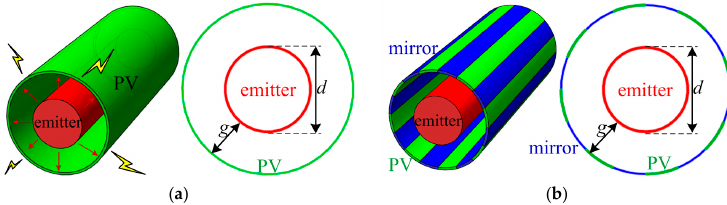
Figure 1. Schematics of the concentric tubular thermophotovoltaic (TPV) design. Red, green and blue represent the emitter, the photovoltaic (PV) cells, and the mirrors, respectively. ( a ) Outer tube fully covered by photovoltaic (PV) cells; ( b ) Outer tube consists of photovoltaic (PV) cells and mirrors.